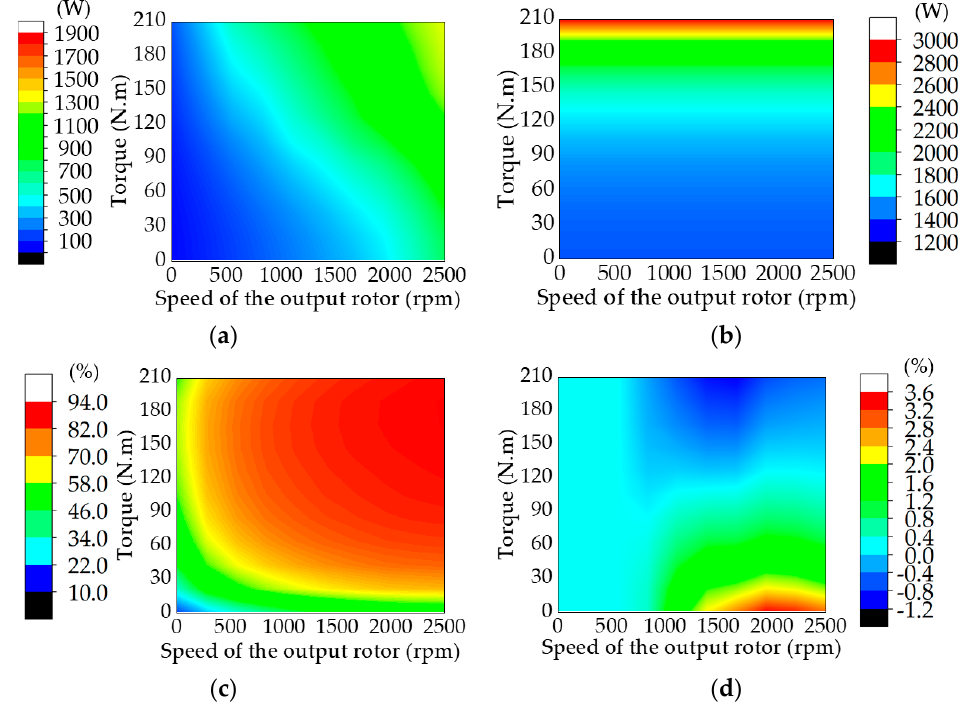
Figure 8. Loss and efficiency maps in the constant torque region according to the winding frequency when the amplitude of the inner winding current is adjusted and the outer winding current is fixed at the rated current (168 Arms). ( a ) Minimum iron loss map; ( b ) Copper loss map; ( c ) Maximum efficiency map; ( d ) Efficiency difference between Type III and Type I.